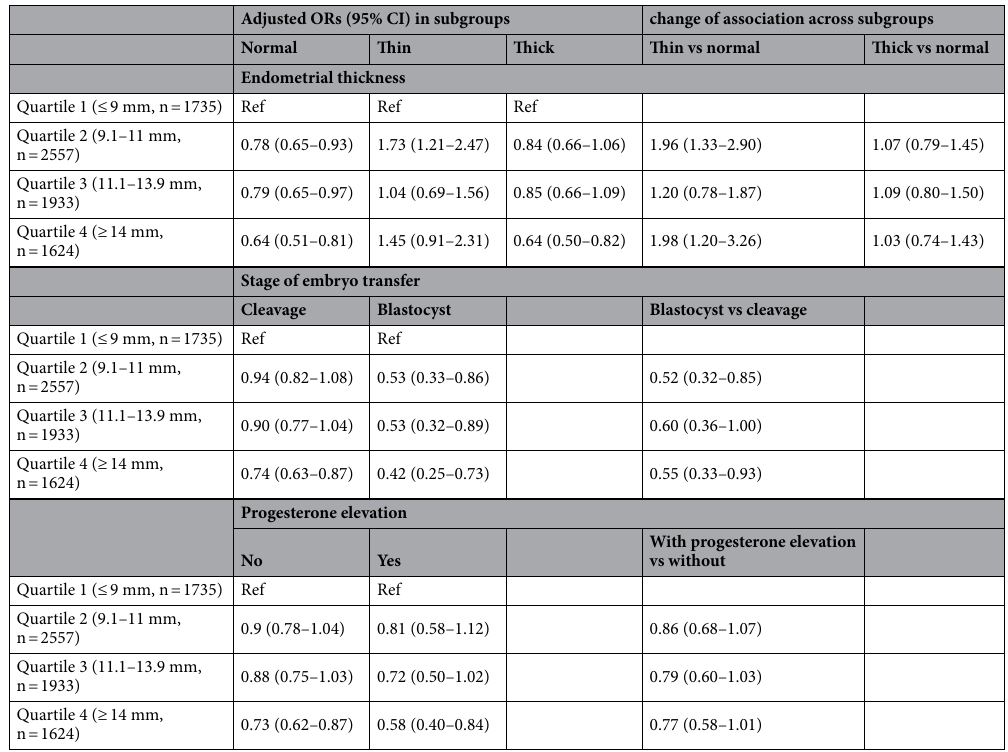
Table 3. Association between embryo transfer depth and pregnancy rate in subgroups and interaction analyses. All models were adjusted for female`s age, duration of infertility, hydrosalpinx, the number of oocytes retrieved, starting dose of stimulation, type of GnRH analogues, the number of embryos transferred, endometrial thickness, endometrial pattern, progesteroneelevation, the development stage of transferred embryos, the presence of at least one good-quality embryo transferred and providers of embryo